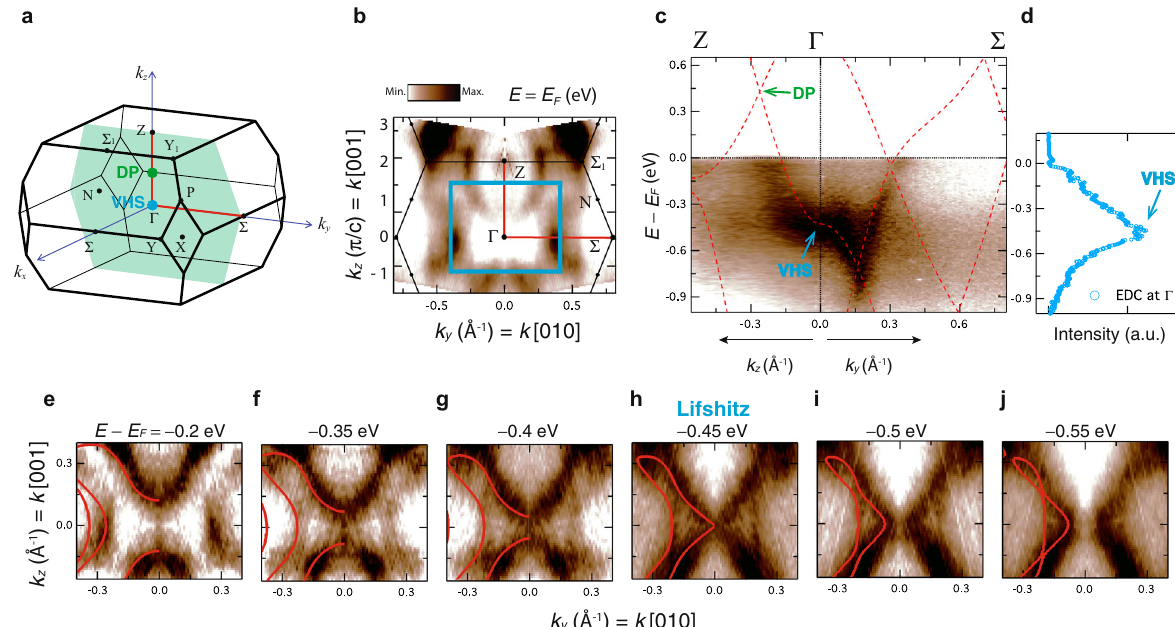
Fig. 3 Lifshitz point and Van Hove singularity in BaAl 4 . a The bulk BZ marked with the location of Dirac point (DP, green dot) and Van Hove singularity of saddle point type (VHS, light blue point). The light green plane represents the location for the constant energy contours shown in ( b , e – j ). b Constant energy map at E F . The light blue square shows the location for ( e – j ). Red lines in ( a , b ) are the high-symmetry lines for the energy and momentum cut shown in ( c ). c ARPES spectra of energy versus momentum cuts along the Z − Γ − Σ . The local maximum and minimum are observed at the same momentum Γ point, showing the saddle point singularity VHS. d Energy-distribution curve (EDC) obtained by integrating the ARPES intensity in the vicinity of Γ point (window size: ±0.02 Å − 1 ). The peak of the EDC marks the VHS at − 450meV where the topology of Fermi surface changes. e – j Series of the symmetrized constant energy maps at E E B ~ − 0.45, − 0.5, and − 0.55 eV, respectively, showing the topology of electronic structure changes at the Lifshitz point ( h ), E lines superposed in these panels here are the DFT calculation results for E B = − 0.27, − 0.4, − 0.45, − 0.497, − 0.55, and − 0.57, respectively. For a direct comparison, all constant energy maps ( b , e – j ) are symmetrized, and these maps and the energy and momentum cut ( c ) shown here are centered at ( kx , ky , kz ) = (0, 0, electronic dispersions are consistent with band structure calcula- tions for all directions. Similar to graphene, multiple Dirac dispersions in BaAl 4 create a saddle-point singularity in between the two DPs in momentum space as a result of a change in electronic topology, reminiscent of a Lifshitz transition in the electronic structure. Figure 3a shows the location of the DP and VHS in the bulk BZ of BaAl 4 . To identify the saddle-point singularity experimentally, we show the energy and momentum dispersion along the Z − Γ − Σ direction (along the red line in Fig. 3a, b) in Fig. 3c. While the tail of the Dirac dispersion has the local energy minimum in between the DPs, the Γ point, the dispersion along the orthogonal direction (in-plane direction, Γ − Σ ) has the opposite curvature, resulting in the saddle-point singularity of band structure, a Van Hove singularity (VHS). The integrated energy- distribution curve (EDC) around the Γ point shown in Fig. 3d clearly indicates the peak of local density of states (DOS) at ~ − 0.45 eV. This peak is consistent with a local DOS maximum in a saddle-point since the band structure is nearly fl at at the VHS. Emergence of a VHS is associated with a Lifshitz transition. Figure 3e – j represents a series of ARPES constant energy maps near the Γ point (see the blue square in Fig. 3b) with various binding energies, emphasizing the change of topology of electronic structures. The energy contours of Dirac dispersions become close to each other toward the Γ point as the binding energy changes to deeper level (shown in Fig. 3e – g). Once it reaches the Lifshitz point (~ − 0.45 eV), the two unconnected tails of Dirac dispersions merge and the electronic topology changes as shown in Fig. 3h – j. This change in electronic topology is also clearly reproduced by the theoretical calculation (The red lines in Fig. 3h – j).